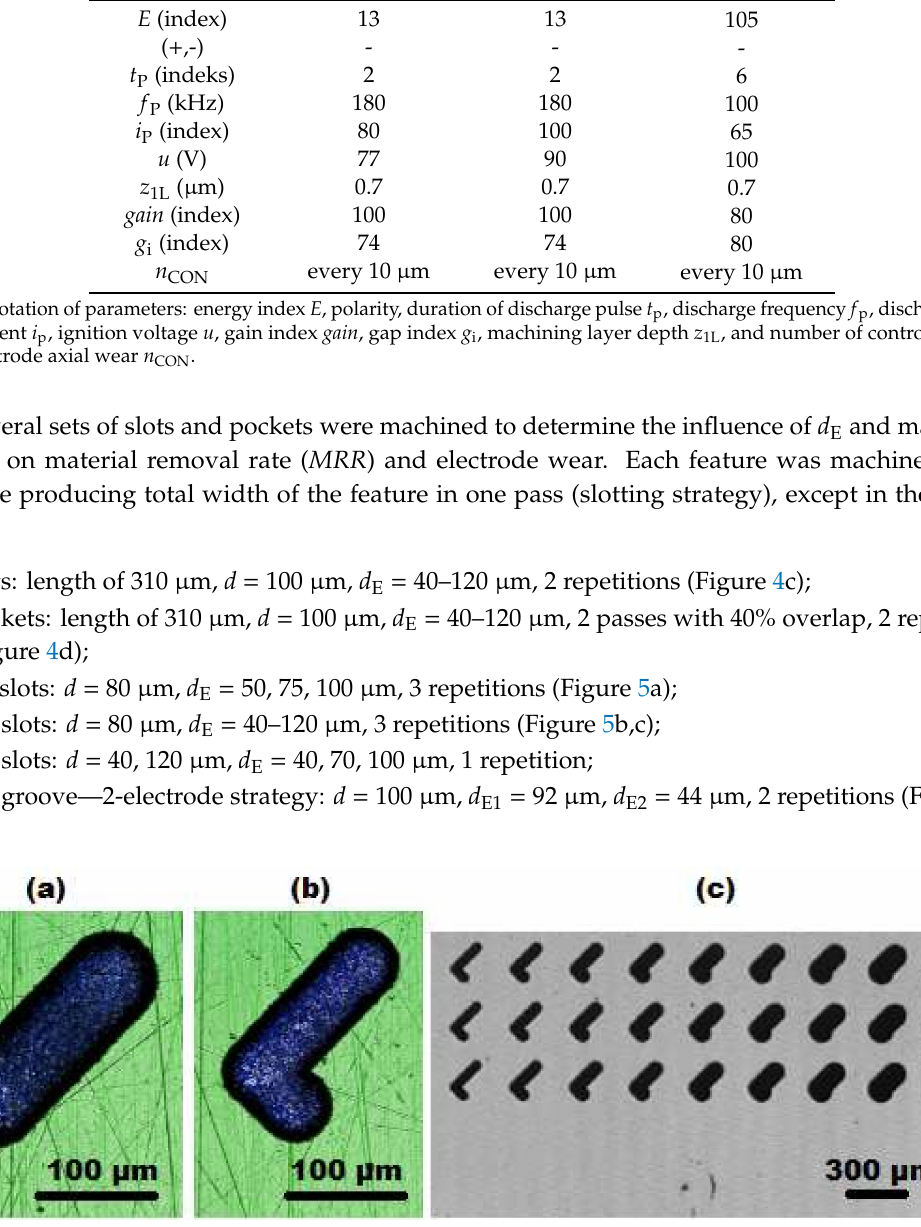
Figure 5. Microscope images of SG and SH slots, which can be implemented in the w = 200 µ m wide microchannel. ( a ) SG slot ( d E = 75 µ m, d = 80 µ m) and ( b ) SH slot ( d E = 60 µ m, d = 80 µ m). ( c ) SH slots ( d E = 40–120 µ m, d = 80 µ